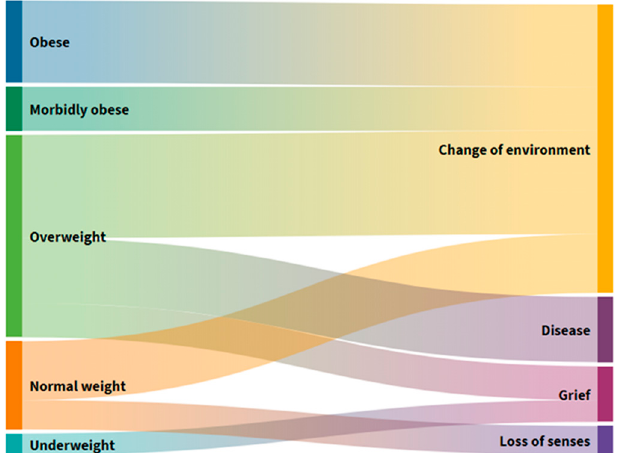
Figure 5. Alluvial diagram of the distribution of users by individual BMI groups and self-reported weight loss cause.